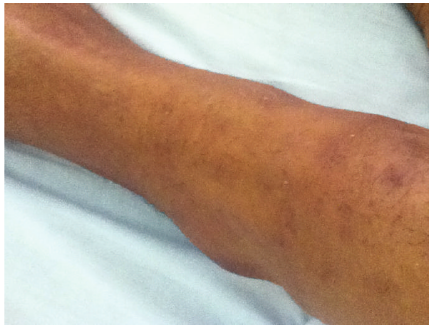
Figure 1: Patchy hyperpigmentations on the patient’s shin.